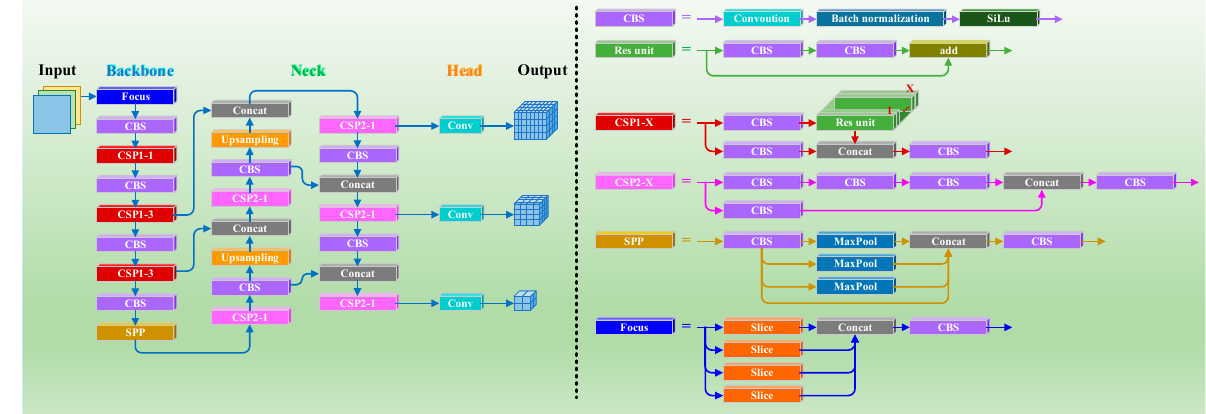
Figure 1. The YOLOv5s structure.